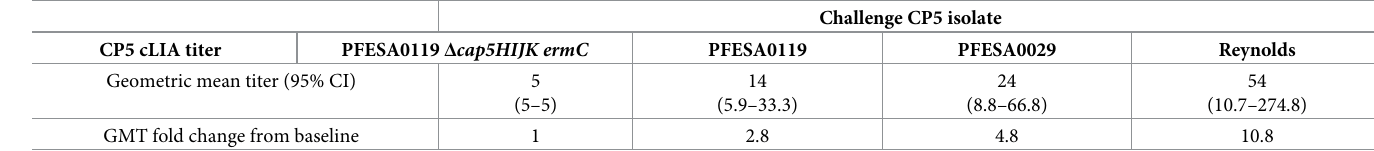
Table 4. Demonstration of specificity of in vivo CP immune responses in mice challenged with S . aureus isolates. CP5 antibody titers in mice challenged with CP5 S . aureus isolates (MSSA strain Reynolds, two USA300 MRSA isolates PFESA0029 [CDC3] and PFESA0119, PFESA0119 Δ cap5HIJK ermC capsule knock-out strains). CD1 mice (7–9 weeks of age, 10 per group) were administered three IP injections of ~ 2x10 6 CFU/animal in 0.5 mL at 0, 6 and 14 weeks, and bled two weeks after the final inoc- ulation. CP5 antibody responses were measured using a CP5 specific cLIA assay. CP5 antibody responses were detected in mice infected with strain Reynolds, and PFESA0029 and PFESA0119 isolates, while the capsule knockout mutant was not able to induce a CP5 antibody response. GMT fold change over the antibody titer of the capsule knockout mutant was calculated for all tested isolates.